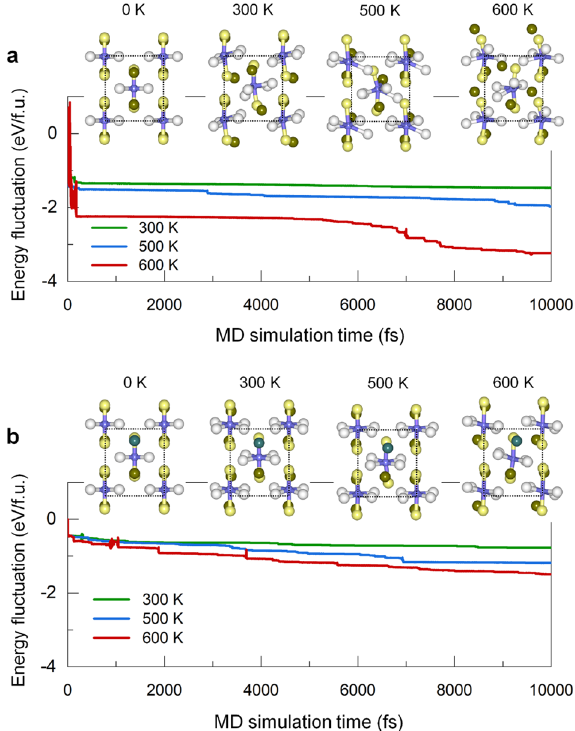
Figure 2. AIMD simulation of the free energy fluctuation of ( a ) Fe 16 N 2 and ( b ) Fe 15 Al 1 N 2 for given temperatures 300, 500, and 600 K. The insets show the side views of the corresponding atomic structures before (0 K) and after the AIMD simulation period of 10 ps. The atomic symbols are the same as used in Fig. 1a. Green sphere in b is the Al